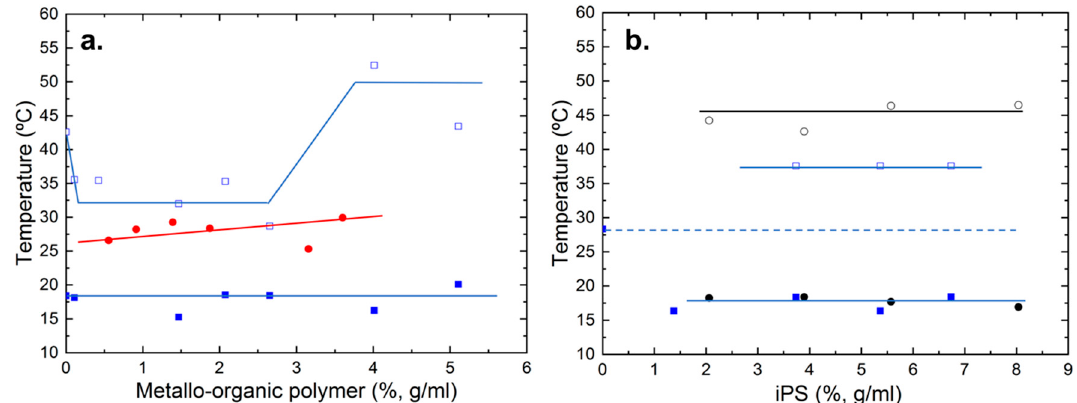
Figure 2: Partial phase diagrams of iPS gels, metallo-organic polymer gels, and hybrid gels obtained upon heating. To build this diagram, first and third endothermic peaks of the hybrid gels corresponding to the iPS gel were chosen: ( a ) Partial phase diagram obtained upon heating for the iPS / metallo-organic polymer / cis-decaline hybrid gels with a fixed concentration of iPS (4%, g / mL) and variable metallo-organic polymer gel. Pure metallo-organic polymer gel (red circle), first (blue square), and third endothermic peak (blue empty square) of the hybrid gel are plotted. ( b ) Partial phase diagram obtained on heating for the iPS / metallo-organic polymer / cis-decaline hybrid gels with a fixed concentration of metallo-organic polymer (1.4%, g / mL) and variable concentration of iPS: First (black circle, full symbol) and third endothermic peak of pure iPS (black circle, empty symbol), and first (blue square, full symbol) and third endothermic peak of the hybrid gel (blue square, empty symbol) are represented.